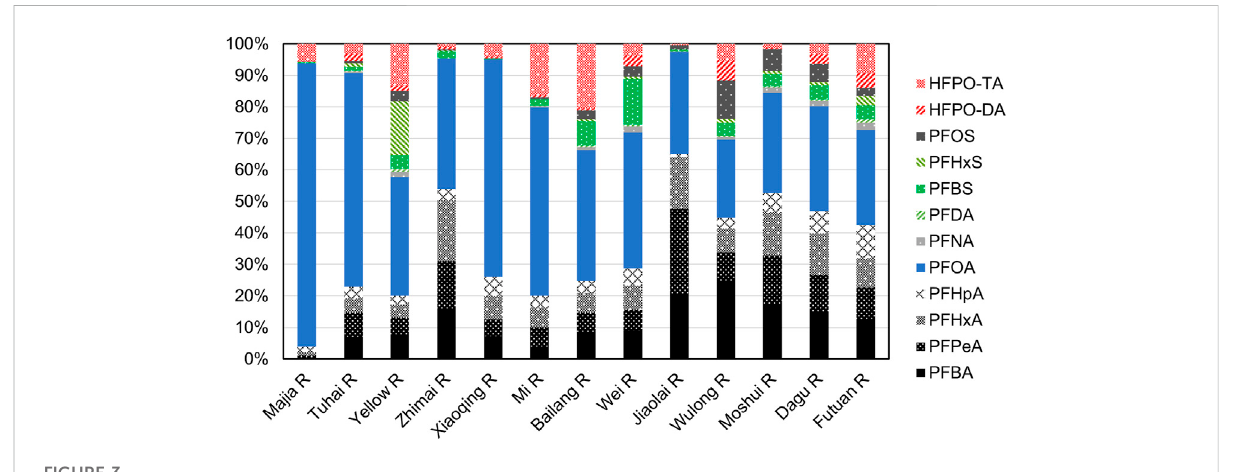
FIGURE 3 Relative contributions of PFAS in the rivers of Shandong,